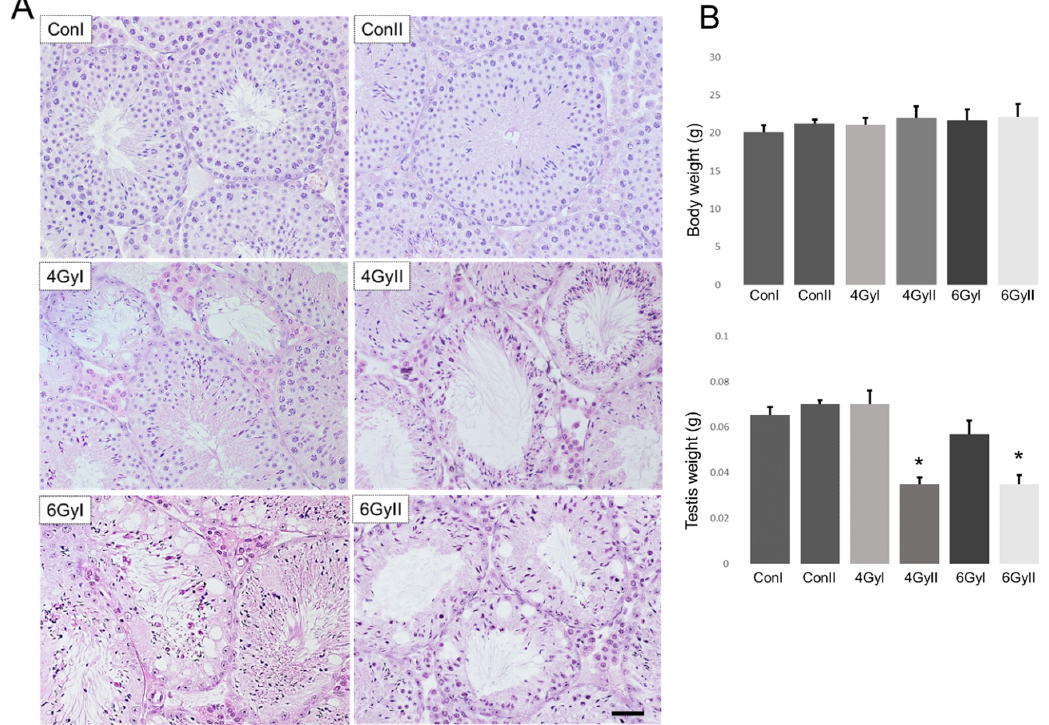
Figure 1. Testicular histology, testis weight, and body weight in each group ( n = 5). ( A ) Testes sections show morphology in groups I and II. Intact seminiferous tubules showing normal germinal epithelium from the spermatogonia to spermatozoa are observed in ConI and ConII. Damaged seminiferous tubules with azoospermia are observed in the other groups of 4GyI, 4GyII, 6GyI, and 6GyII. The presence of both atrophic and intact seminiferous tubules with spermatogenesis was observed in the group IV mice. Normal-appearing seminiferous tubules are observed in the group V mice. Scale bar = 50 μ m. ( B ) The body weight and testis weight in each group. * p < 0.05 vs. control